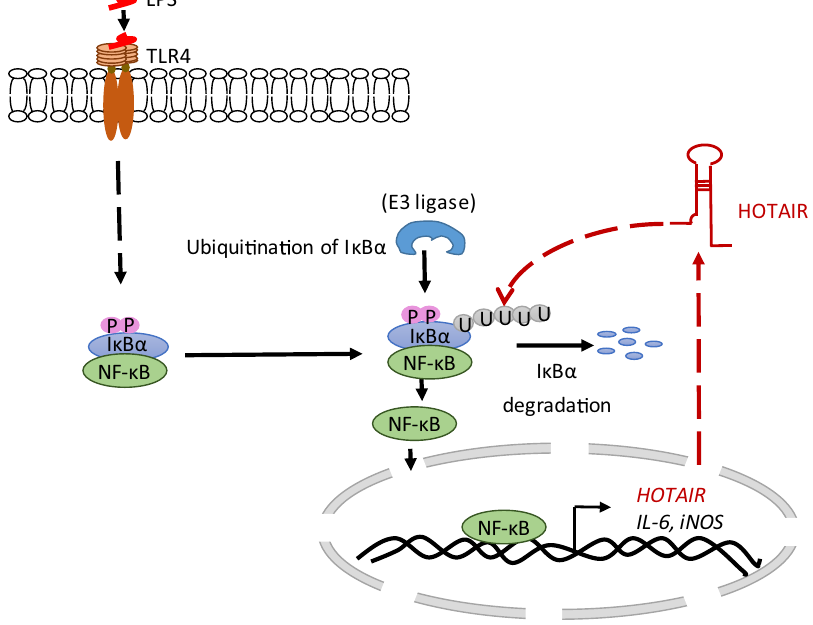
Figure 8. Proposed model for LPS-mediated HOTAIR induction in immune cells. When TLR4 senses LPS, NF- κ B is activated that induces IL-6, iNOS and HOTAIR expression. In turn, HOTAIR facilitates I κ B α degradation and enhances NF- κ B activation, nuclear translocation and binding to NF- κ B regulated genes (pro- inflammatory genes such as IL-6, iNOS) inducing their